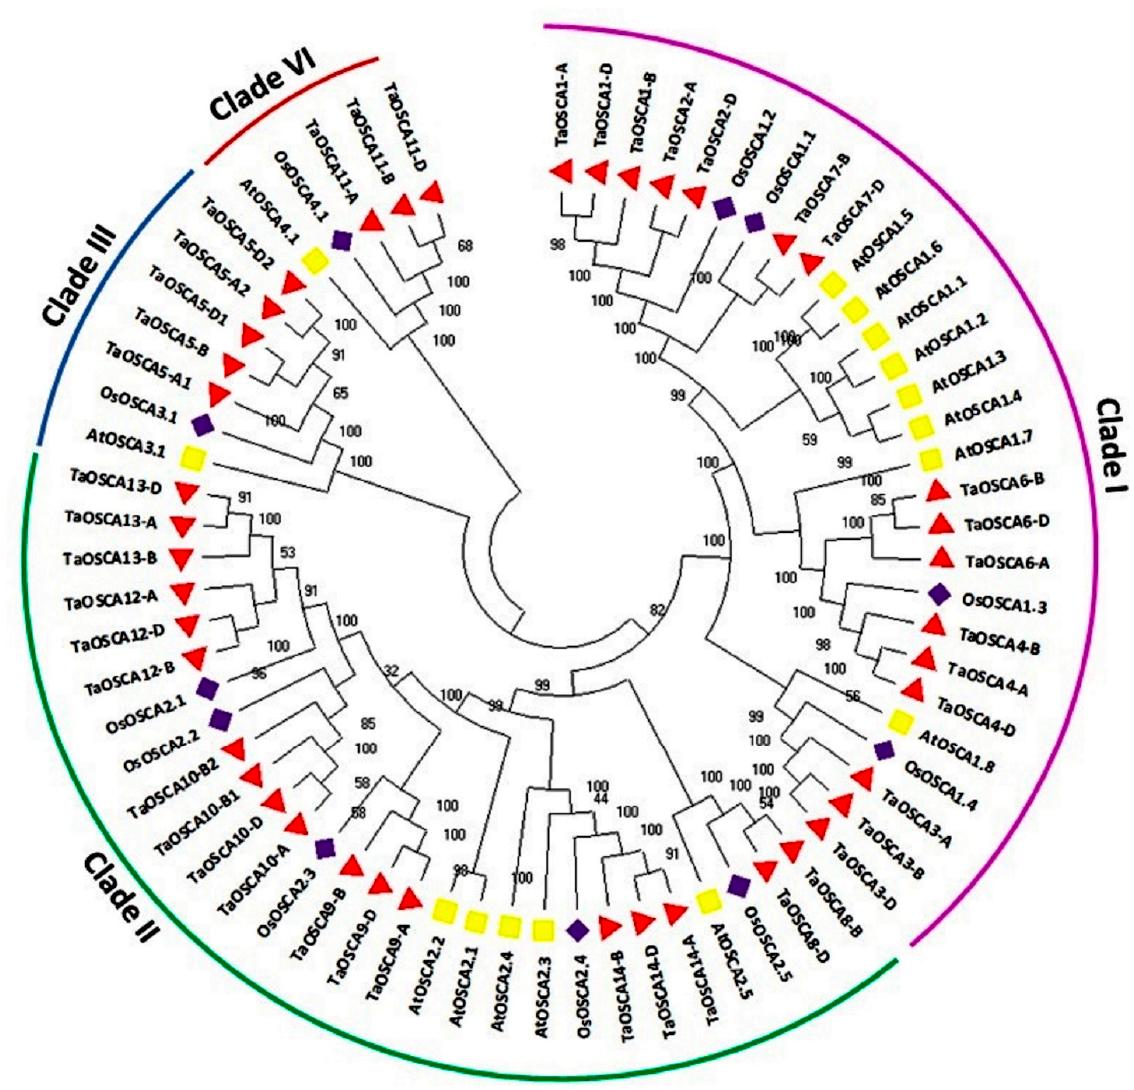
Figure 2. Phylogenetic tree analysis of A. thaliana, O. sativa, and T. aestivum using full-length peptide of OSCAs. The figure shows the phylogenetic tree of OSCA built by the neighbor-joining approach with 1000 bootstrap values using MEGA X software. The phylogenetic tree displays the clustering of the OSCA proteins of three plant species in different clades I-IV; each clade is colored